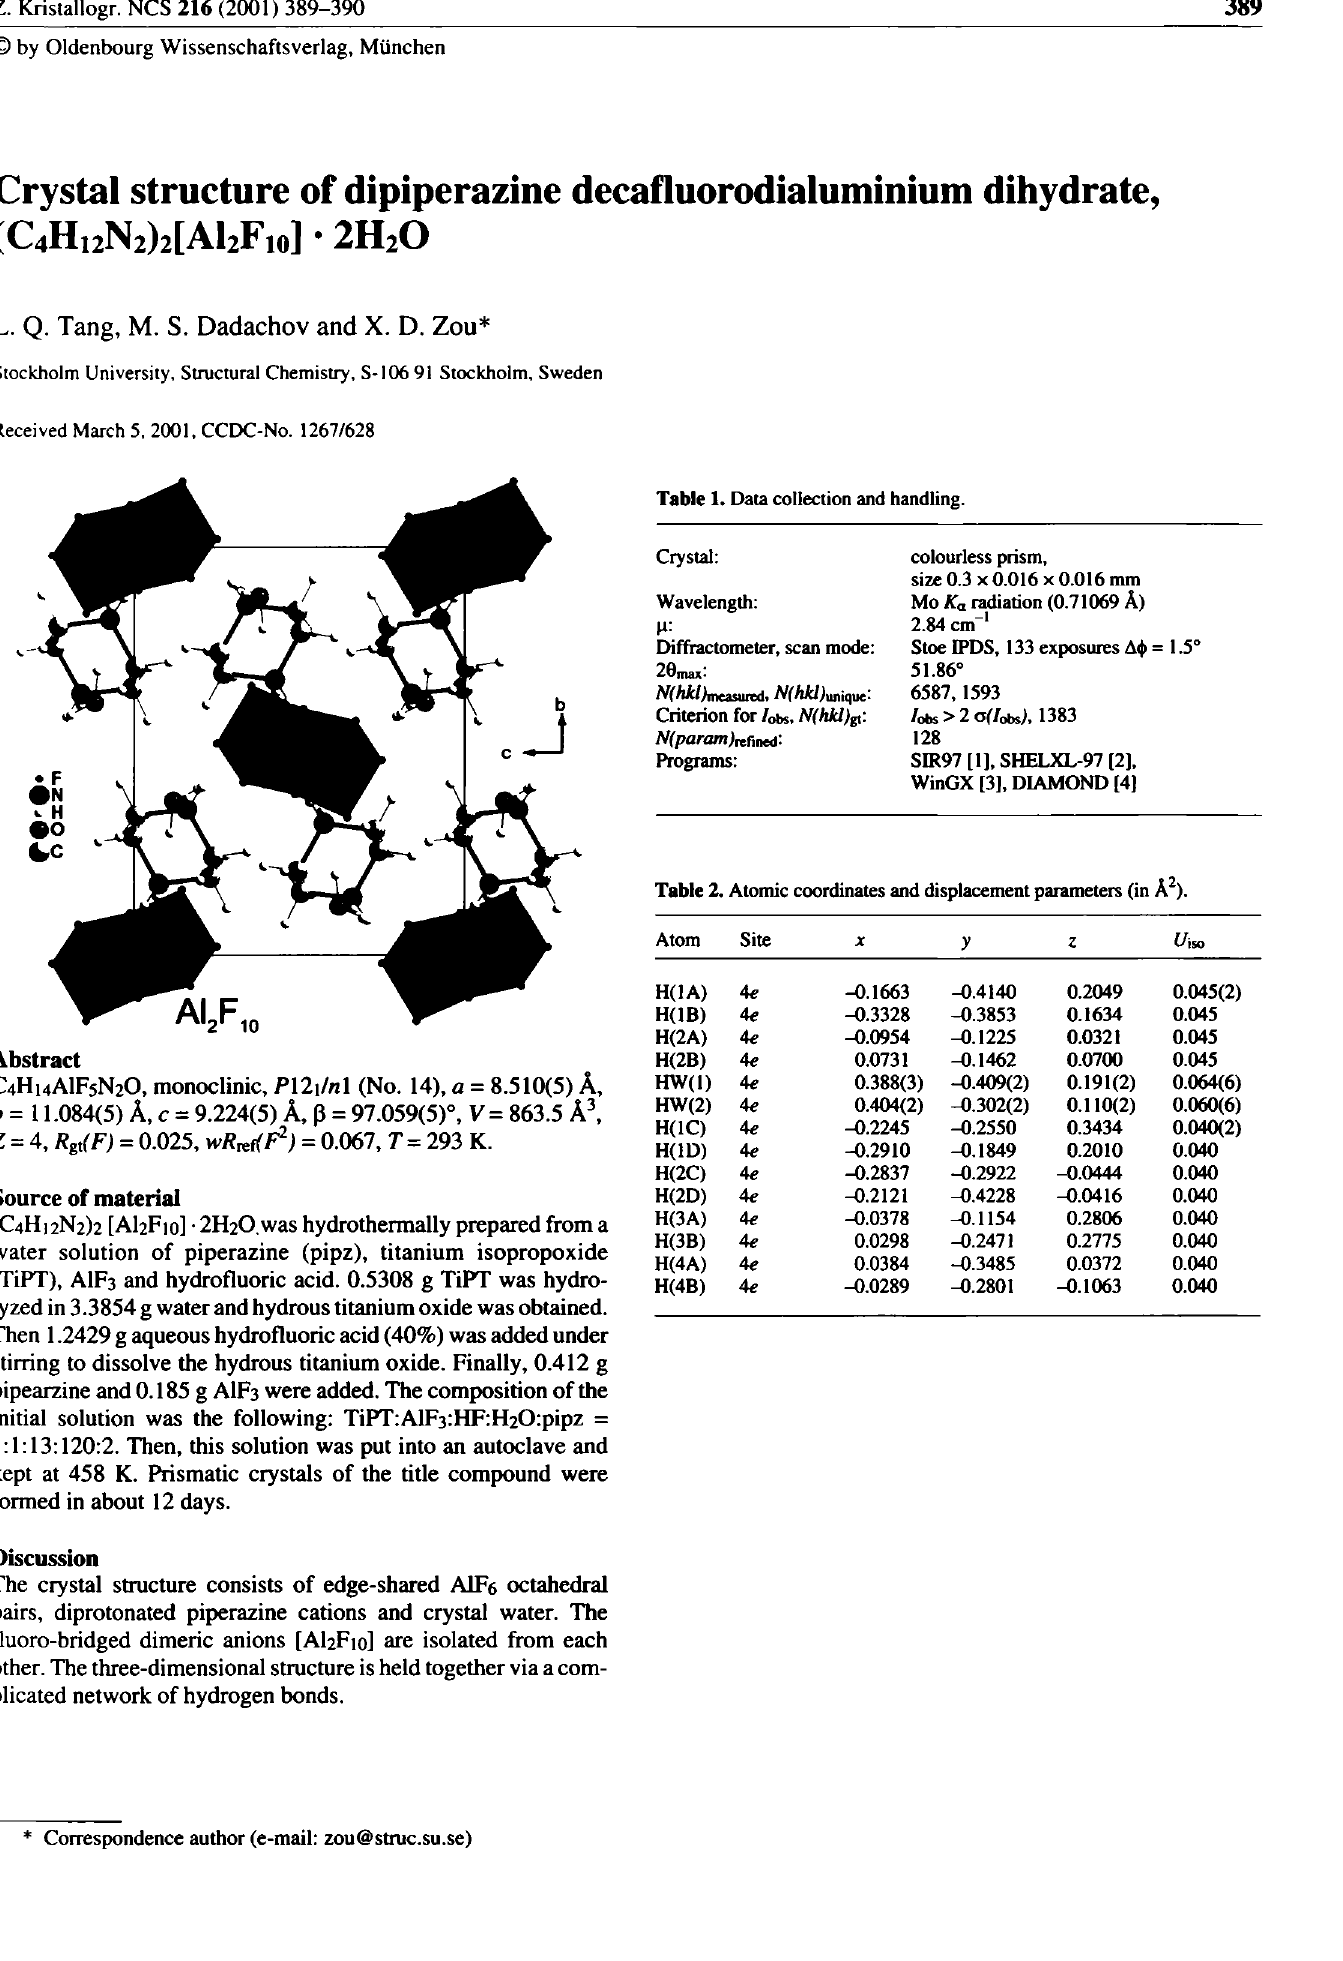
Table 1. Data collection and handling.